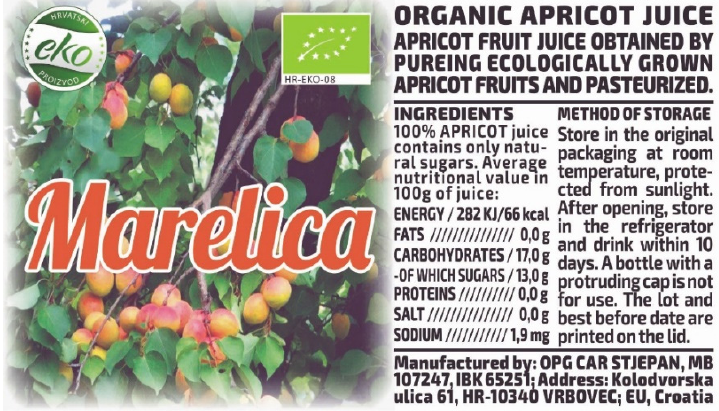
Figure 1. Original design “V” for the visible (RGB) spectrum.